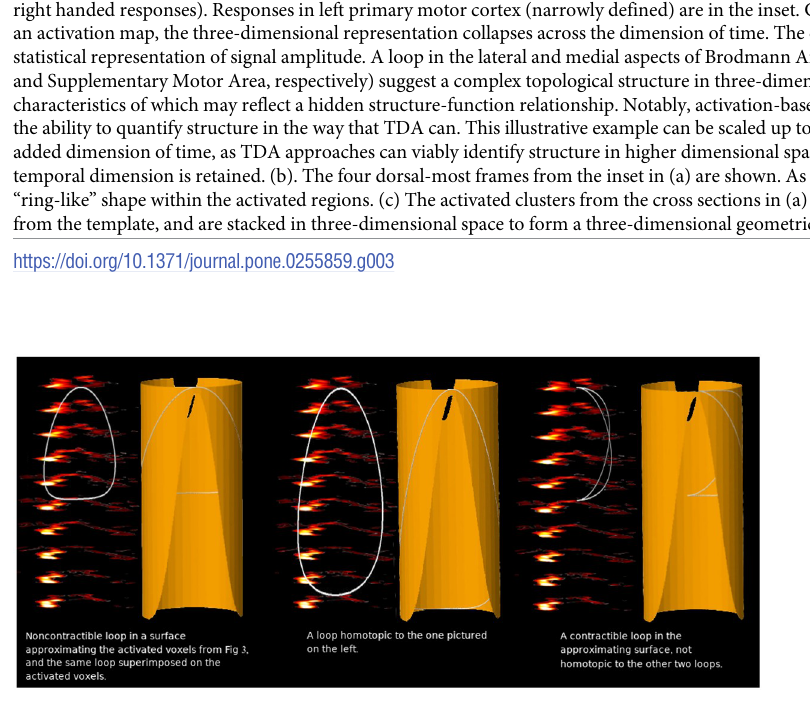
Fig 4. Continuing from Fig 3 see that the two loops on the left are homotopic—they are continuously deformable into one another—in the idealized surface. We present them along with their projections to the fMRI cross-sections which the idealized surface is intended to resemble. The rightmost loop is not homotopic to the two on the left: it is not possible to continuously deform the right-hand loop into either of the two left-hand loops without leaving the idealized surface. In other words, there is no way to continuously deform the right-hand loop into either of the left-hand loops without travelling “too far” in stereotactic space from the activated cluster.